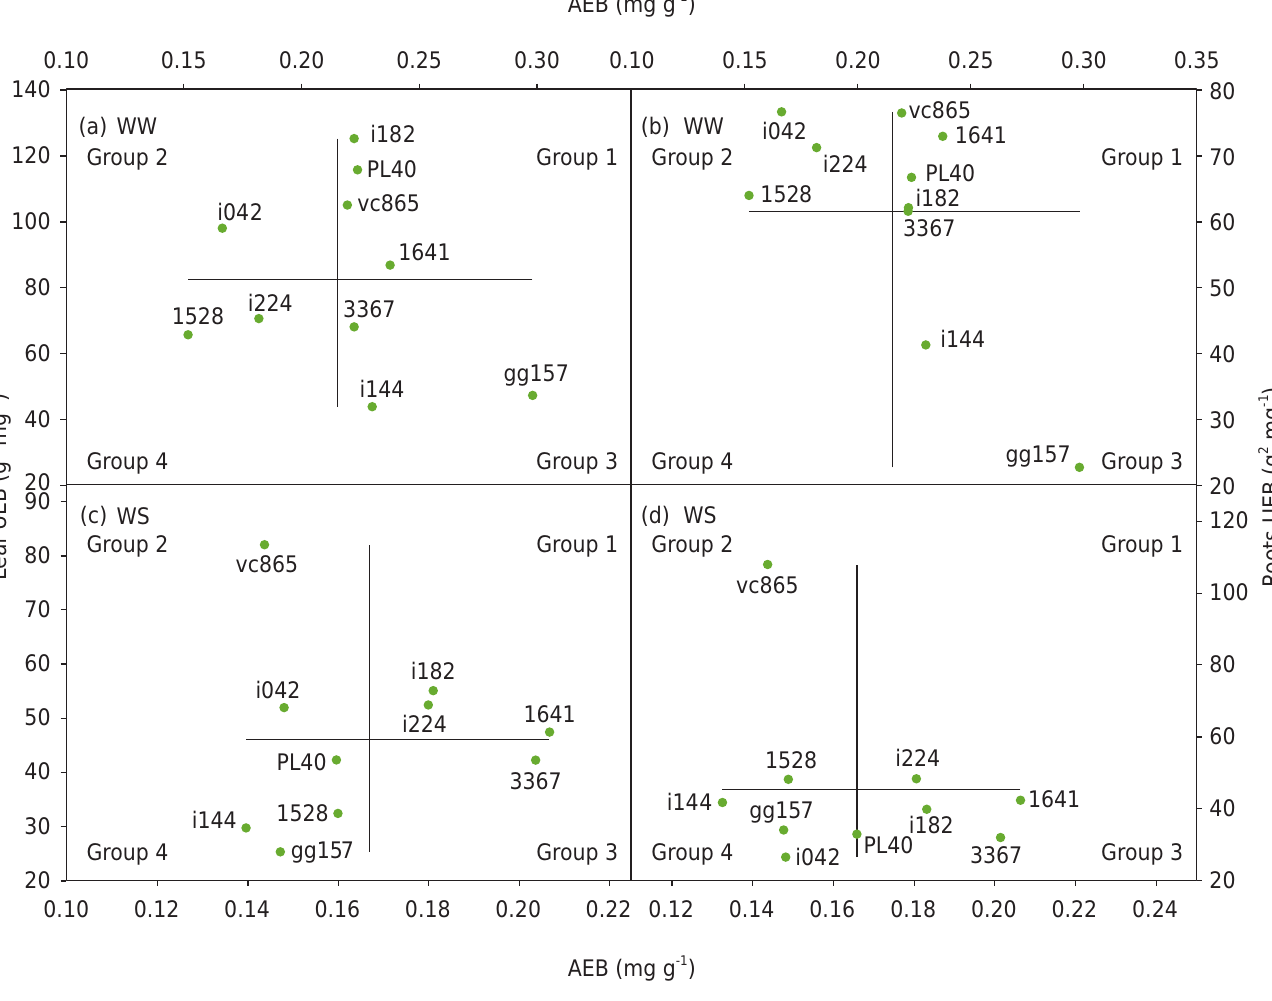
Figure 3. Boron absorption efficiency (AEB) and B use efficiency in leaves (leaf UEB) (a) and roots (root UEB) (b) of well-watered (WW) plants; and B absorption efficiency (AEB) and B use efficiency in leaves (leaf UEB) (c) and roots (root UEB) (d) of water-stressed (WS) seedlings of ten Eucalyptus